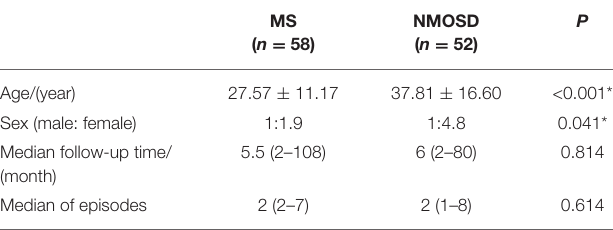
TABLE 1 | General information of patients. TABLE 2 | General information and clinical features of